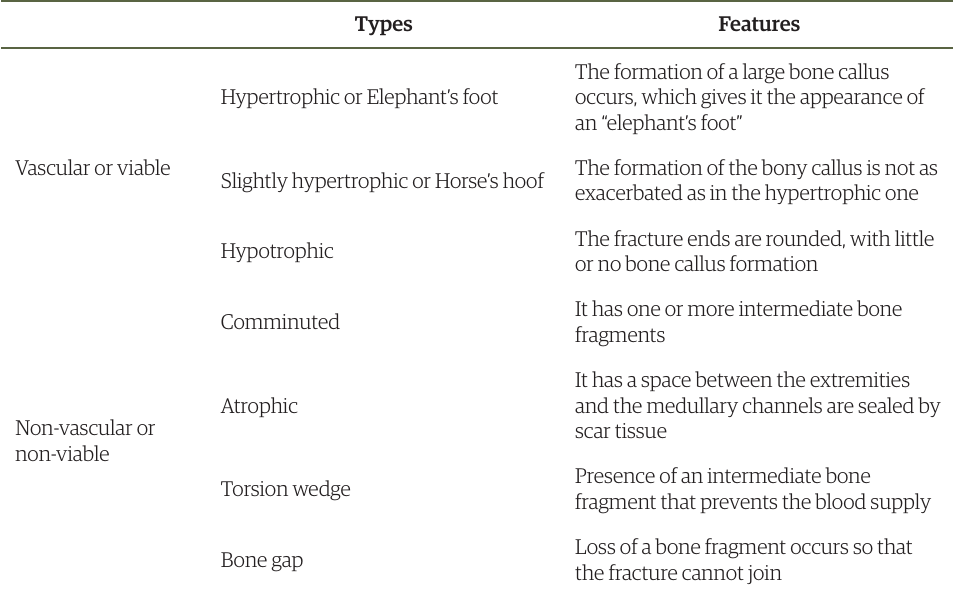
Figure 1. Flowchart of creation of 3D models of fracture non-union (3D Table 1. Classification of types of fracture non-union.